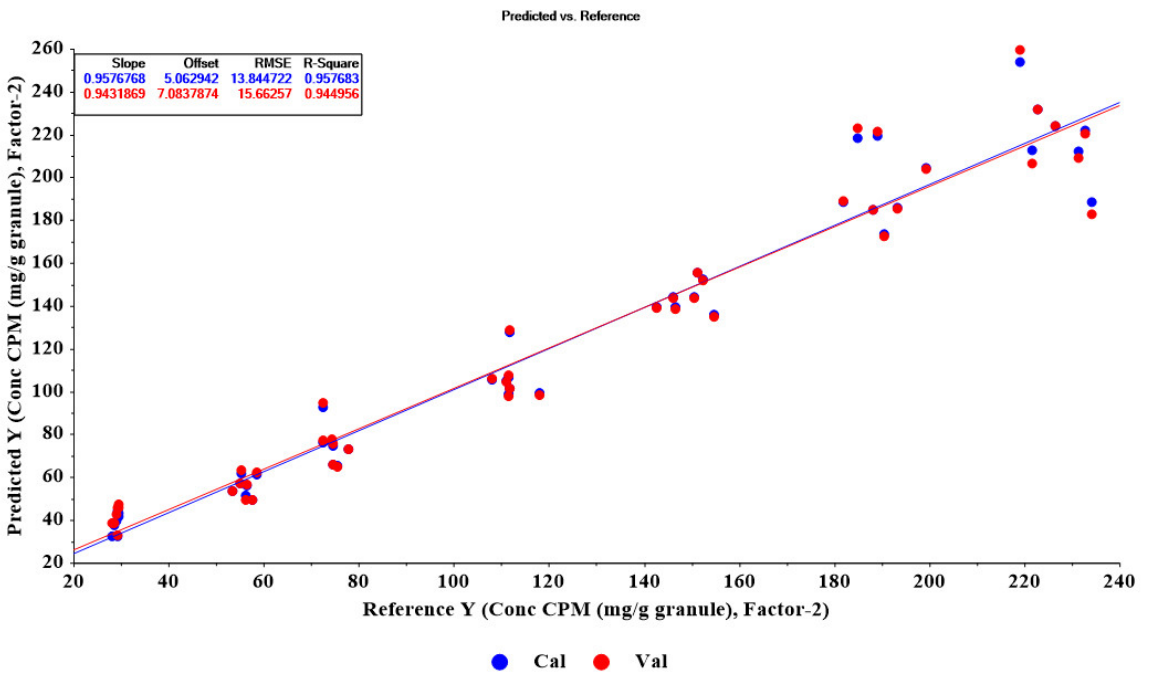
Figure 4. Plots of calibration and cross-validation of the optimum model for granules. Calibration